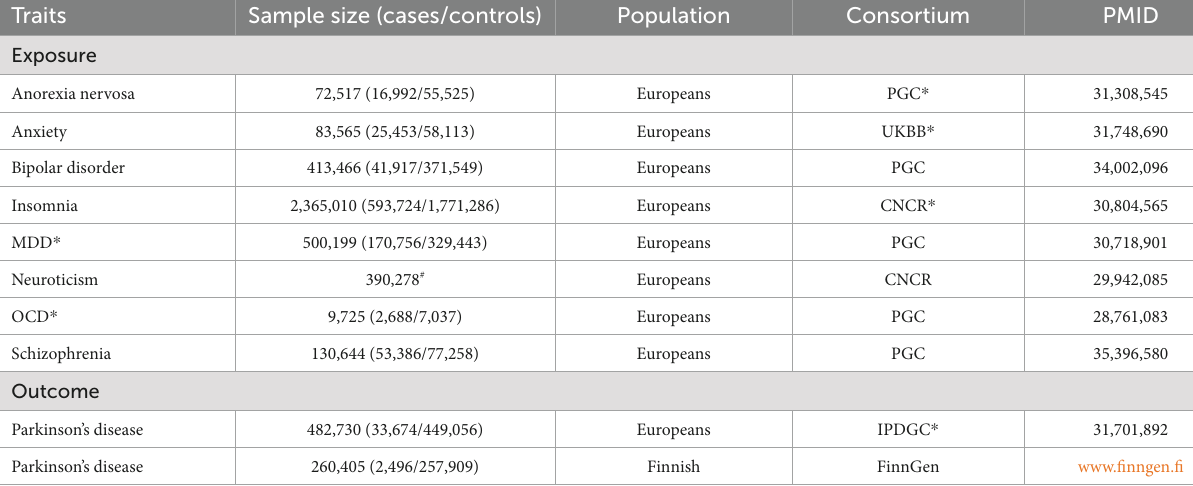
TABLE 1 Characteristics of GWASs used for each disorder. Traits Sample size (cases/controls)